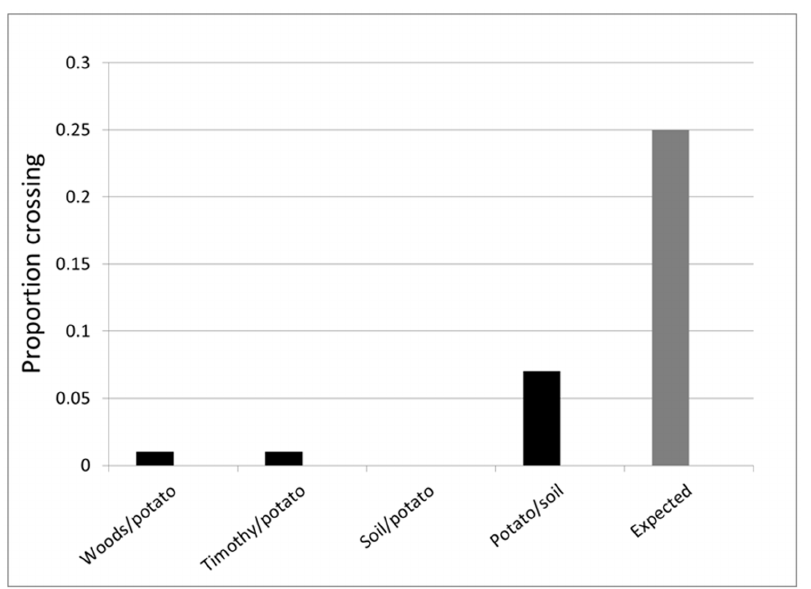
Figure 2. Proportion of Colorado potato beetle crossing a mixed border. Proportion of Leptinotarsa decemlineata leaving the potato plot by crossing the mixed border: woodland, timothy, soil (bare ground) or soil (bare ground) rotated 180 u from the previous one. Values , 0.25 indicate a bias against crossing the border because the mixed border constitutes 25% of the perimeter of the potato plot. Crossings at the potato/soil border did not differ significantly from random ( x 2 =9.56, df=1, P=0.002). Differences between expected and observed values for the other treatments could not be tested using a chi-square goodness-of-fit test because of the low crossing frequencies in spite of the large number of replications.